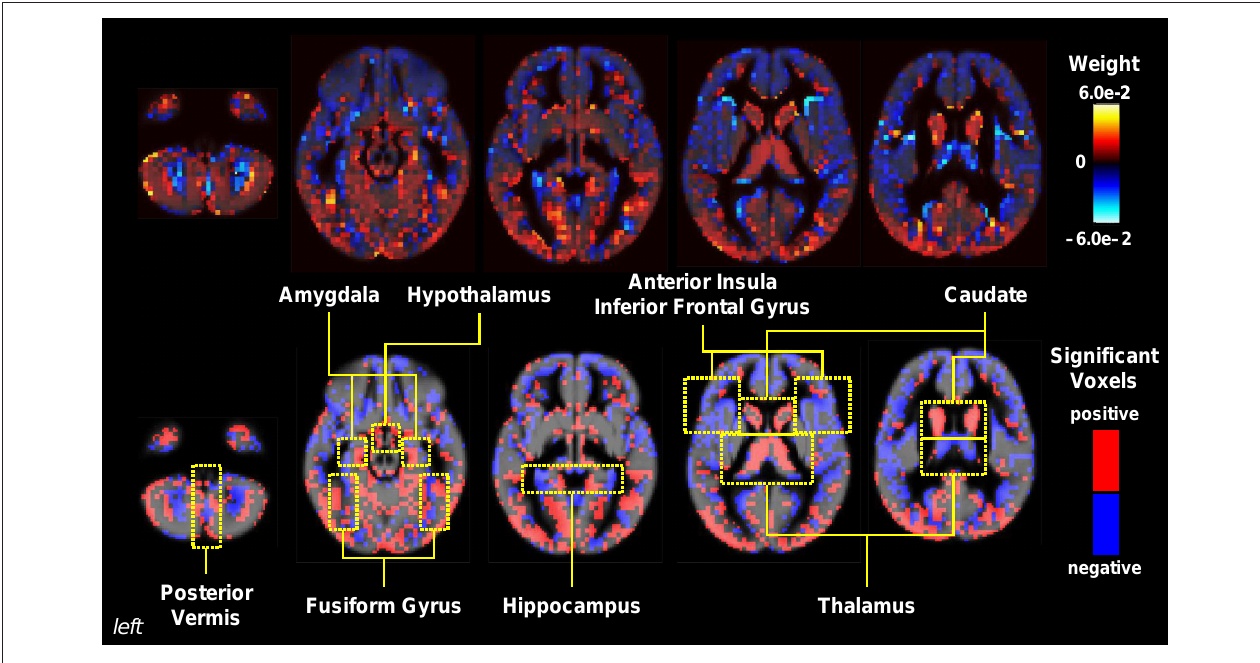
FIGURE 3 | Pattern classifi cation results for FXS versus TD/DD; classifi cation rates above 90% were achieved in this analysis. Whole-brain representation of pattern classifi cation results from FXS versus TD or DD using all gray matter voxels. Axial brain images of weight vectors from leave-one-out